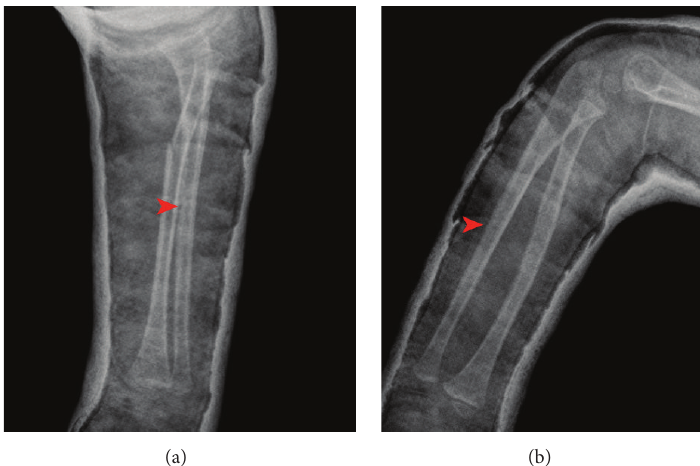
Figure 3: Anatomic reduction of the ulnar fracture in AP (a) and lateral (b) views. Arrow heads show hardly recognizable ulnar fracture lines.